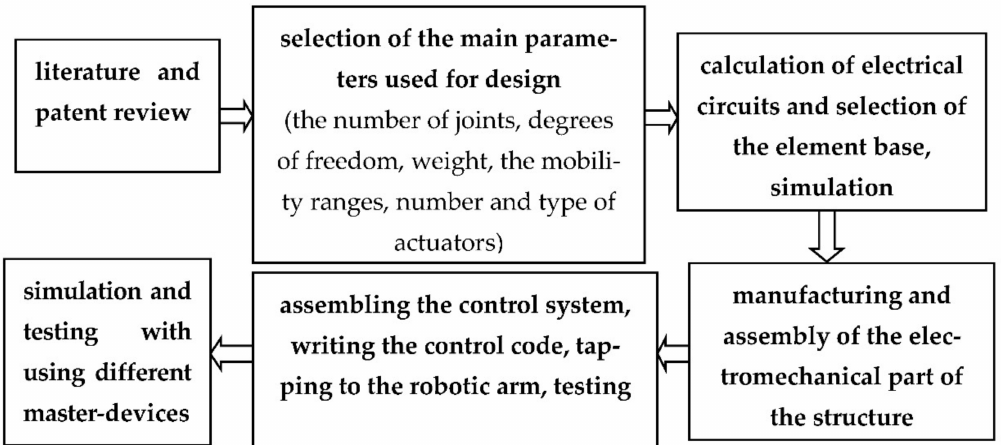
Figure 1. The flowchart of the main stages of the